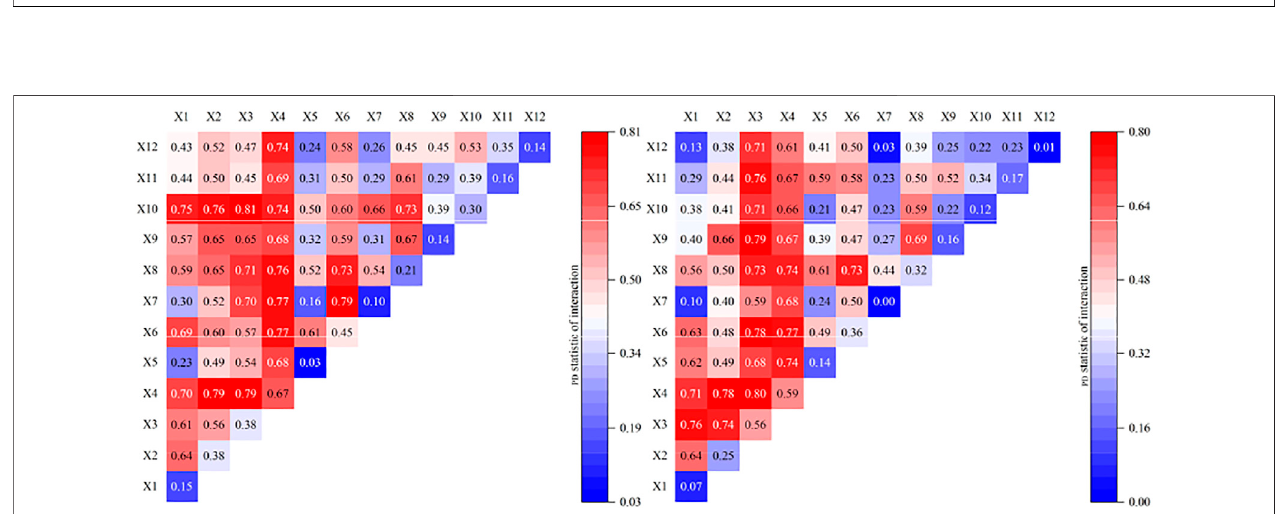
FIGURE 10 | Ecological detector results for driving factors on carbon emission in 2003 and 2019.